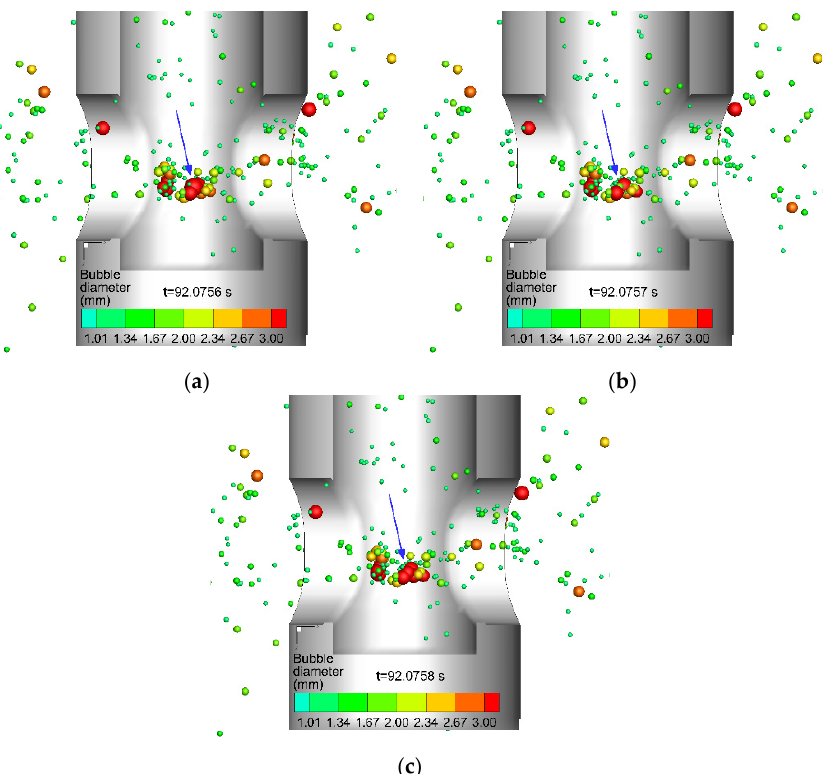
Figure 8. The typical process of the breakup of bubbles (marked by a blue arrow), ( a ) t = 92.0756 s, ( b ) t = 92.0757 s, and ( c ) t = 92.0758 s.